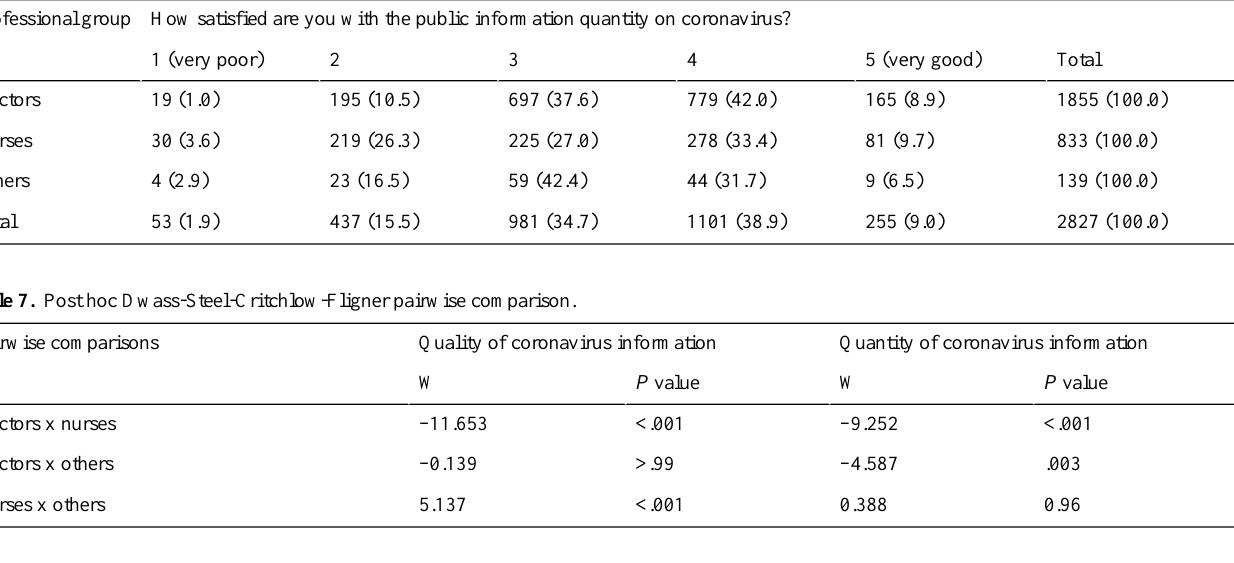
Table 6. Perception of the information quantity on the coronavirus among professional groups.